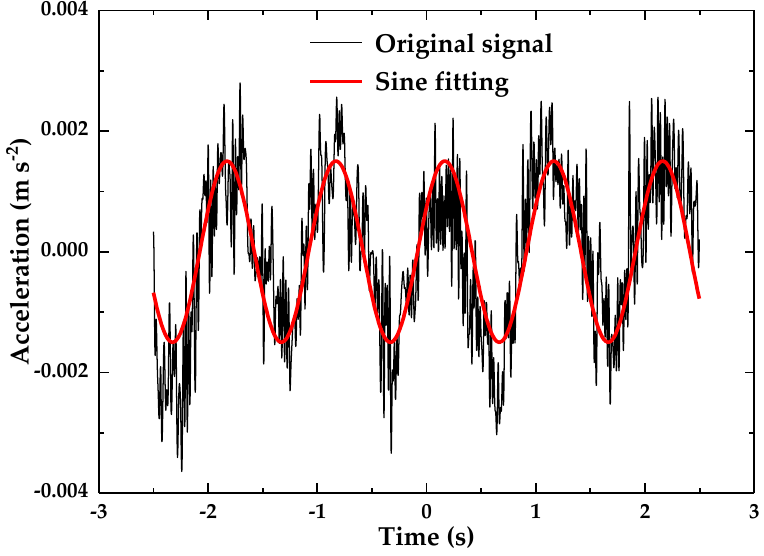
Figure 11. The resolution of the accelerometer.